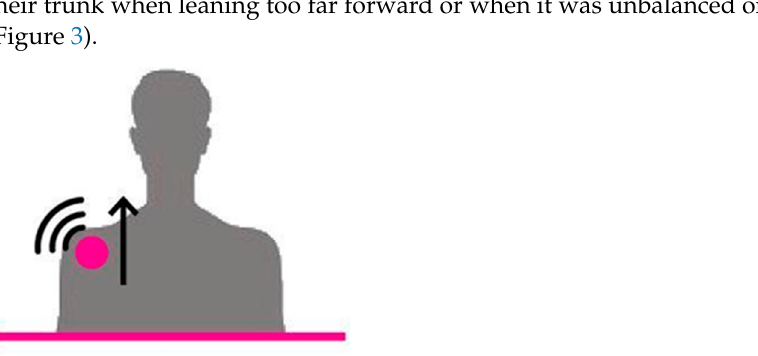
Figure 3. When the cue was submitted to the correct mediolateral inclination, the affected (lowered) shoulder was raised.